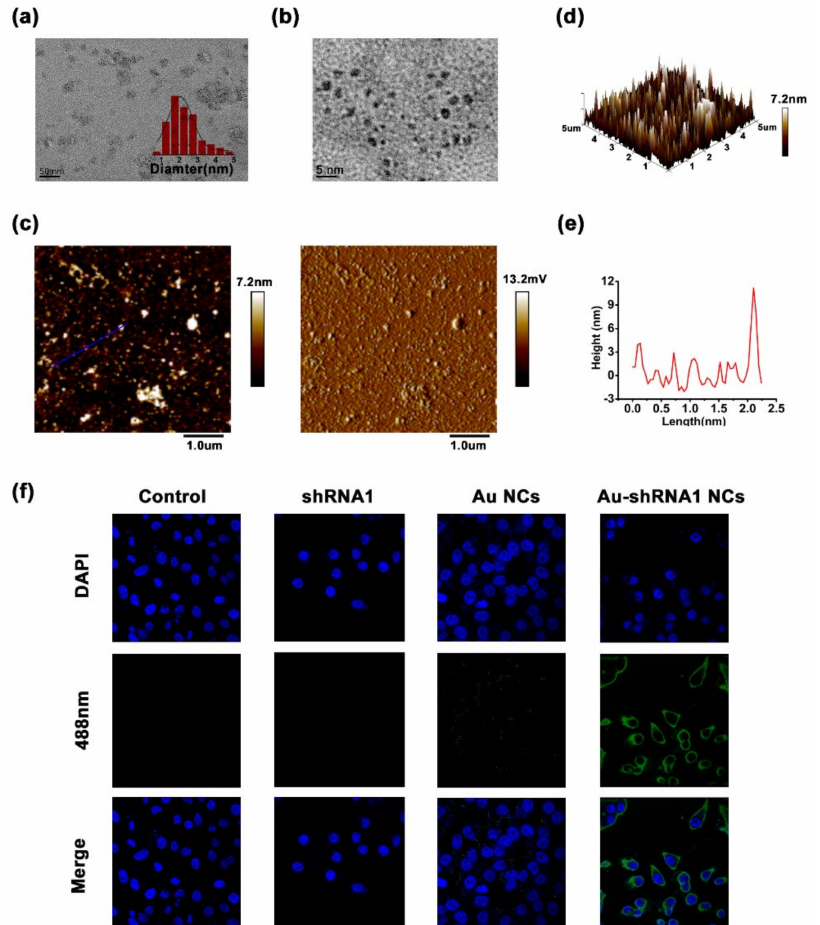
Figure 4. Physicochemical characteristics of bio-self-assembled Au–shRNA1 NCs. ( a ) Typical TEM and ( b ) a higher magnification TEM image of Au–shRNA1 NCs obtained from HepG2 cells after 48 h of culture with HAuCl 4 (5 µ M) and shRNA1 (3 ng/ µ L). ( c ) Typical AFM height diagram ( left ) and corresponding phase diagram ( right ) of the isolated Au–shRNA1 NCs. ( d ) A 3D model diagram corresponding to ( c ). ( e ) Height analysis of the underlined area in (c) ( left ). ( f ) Laser confocal fluorescence images of HepG2 cells cultured with DMEM, the shRNA1, gold salt, or both the shRNA1 and gold salt. After excitement at 488 nm, visualization of biosynthetic fluorescent Au–shRNA1 NCs in HepG2 cells by fluorescence imaging DAPI was used for nucleic staining. In the above tests, the concentration of shRNA1 was 3 ng/ µ L, while that of HAuCl 4 was 5 µ M. Interestingly, confocal immunofluorescence imaging of a single tumor cell, as shown in Figure 5d, co-incubating gold salt and the shRNA1 similarly increased the number of RFP-LC3 positive dots (red), while decreased the number of LAMP2 positive spots (green). The number of p62 positive spots increased in shRNA1 and gold salt transfected cells, while the ratio of p62-LAMP2 pooled (merge) spots/p62 spots decreased compared to other cells (seen in Figure 5e). In addition, RFP-positive/p62 puncta were partly colocalized with LAMP2 in HepG2 cells co-incubated with gold salt and the shRNA1. Through